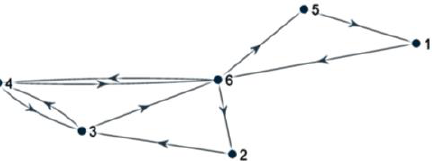
Figure 19. Network Layer of the understudied